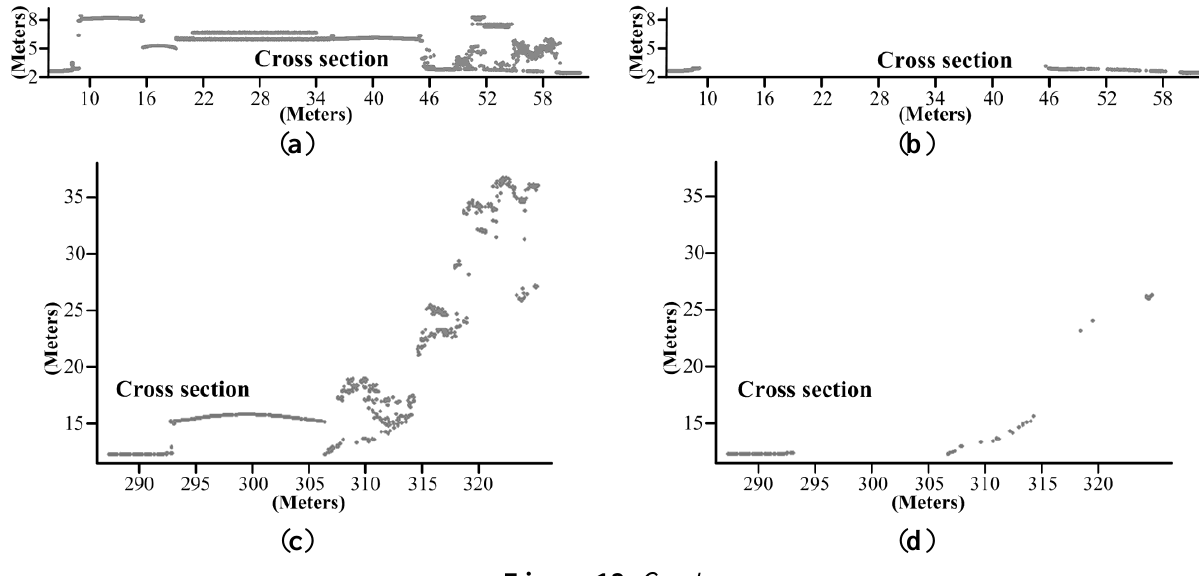
Figure 12. Preservation of terrain discontinuities: ( a ), ( b ) and ( c ) are cross sections; ( d ) is the terrain details; ( e ) is the raw point data; ( f ) is the DTM generated by SGF.